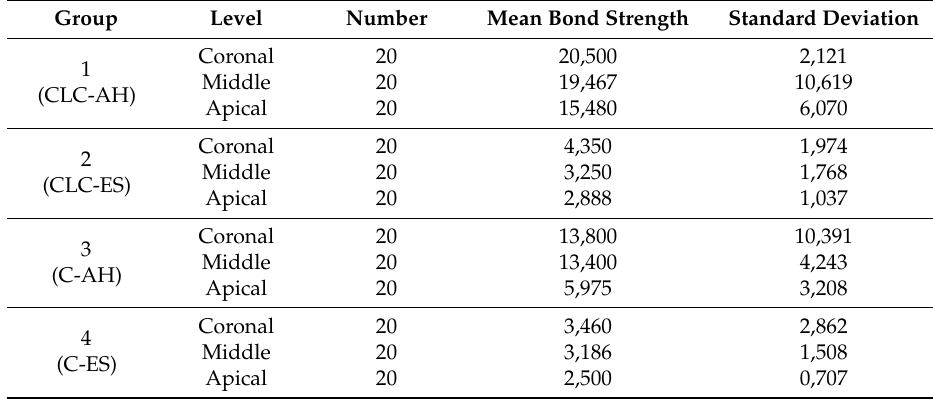
Table 2. Descriptive statistics of mean push-out bond strengths (MPa) and standard deviations at three levels for all